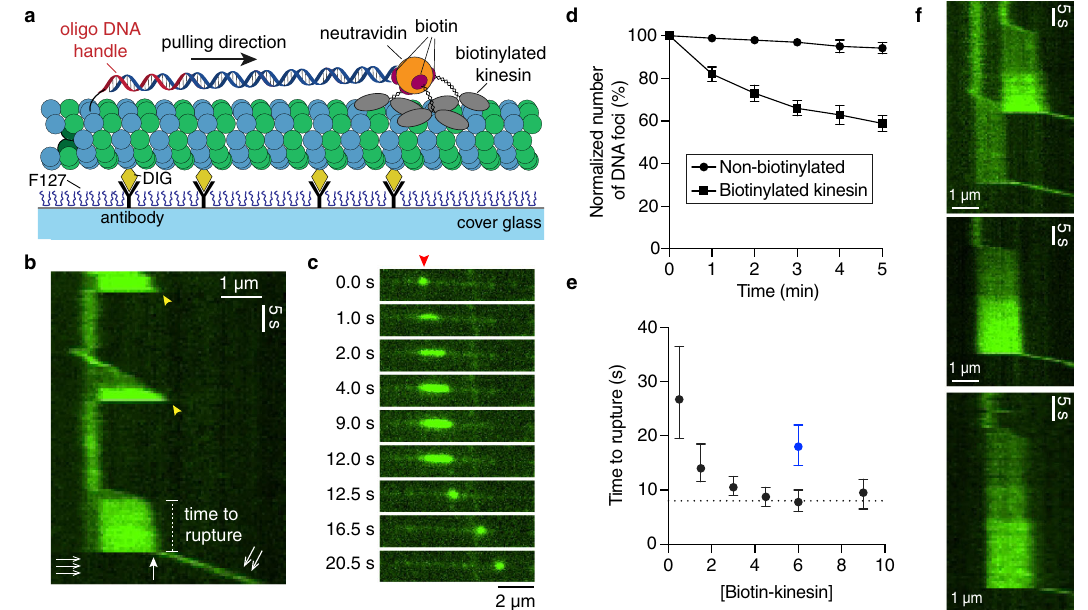
Fig. 5 Kinesin-1 pulled out tubulin subunits from the GDP-microtubule lattice. a Experimental scheme of the motor-pulling assay. GDP-tubulin subunit attached to a DNA linker (3.8 kb) was pulled by biotinylated kinesin-1 molecules along the microtubule axis. The GDP-microtubules were stabilized with GMPCPP-tubulin caps on both ends (not shown for simplicity). b Example kymograph of kinesin-1 stretching a DNA-linker (stained by SYTOX Green) and pulling out a GDP-tubulin subunit. The dissociation of kinesin-1 is indicated with yellow arrowheads. The rupture event corresponding to the dissociation of tubulin was marked by the white arrow. c Time-lapse images of the last stretching event before rupture from the kymograph in b . The DNA molecule of interest is indicated with a red arrowhead. d The number of microtubule-linked DNA molecules remaining after introducing 6 nM of kinesin-1 (either non- biotinylated or biotinylated with ~50% stoichiometry) imaged at 1 frame per minute (error bars: SDs). Biotinylated kinesin-1 led to a signi fi cant reduction of fl uorescent DNA molecules after 5 min as compared to the non-biotinylated kinesin-1 control (two-tailed Welch t -test p = 0.0003; percentage of DNA remained: 59 ± 4% vs. 94 ± 3%; mean ± SD, n = 3 experiments). e Time-to-rupture (error bars: median ± 95% con fi dence interval) decreased with increasing concentration of biotinylated kinesin-1 to a value of ~8 s (dashed line). Data collected from triplicate experiments with n = 108, 105, 130, 122, 112, 99 events at each concentration (from 0.5 nM to 9 nM). Rupture time from taxol-stabilized microtubules is shown in blue ( n = 160 events from triplicates). f Examples of stepwise increase in fl uorescence intensity corresponding to the stepwise increase in force due to the increase in the number of motors engaged in force generation (Supplementary Movie 2 corresponding to the kymograph on the top). An additional example is included in Supplementary Figure